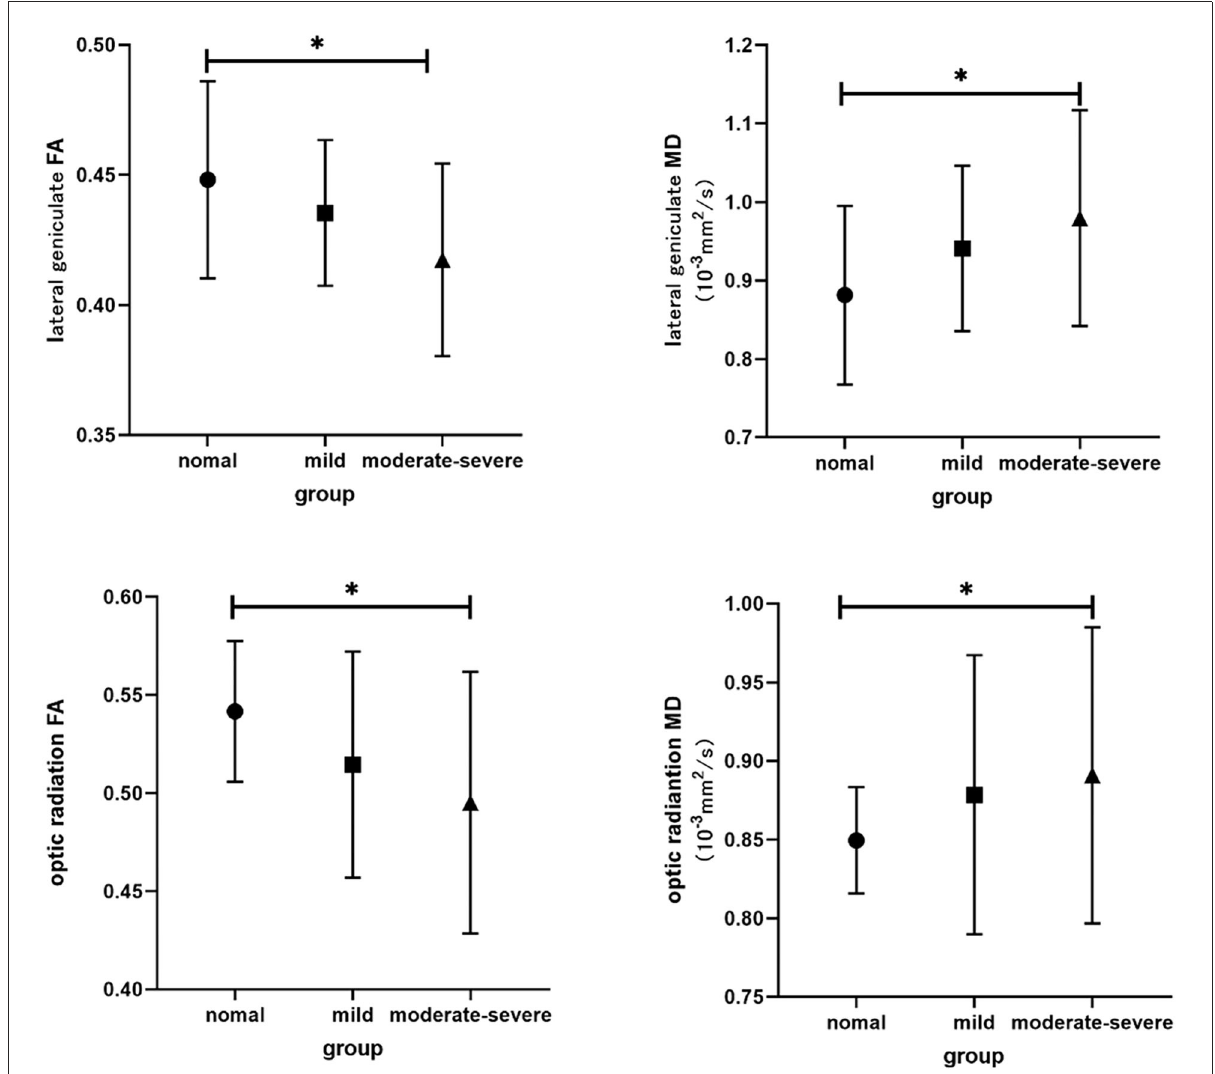
FIGURE2 Bar graphs show comparisons of DTI parameters in visual pathway between groups. The main bars represent the mean value of the parameters and the error bars stand for standard deviation. The asterisk indicates a significant